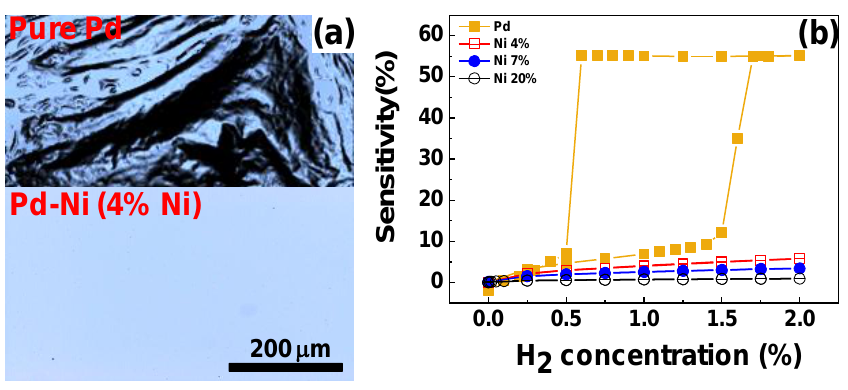
Figure 4. (a) Confocal laser scanning microscopy images of a pure Pd and a Pd-Ni alloy (4% Ni) films after exposure to 2% H alloy films with varying Ni content as a function of H Data reproduced from Lee et al . [82].